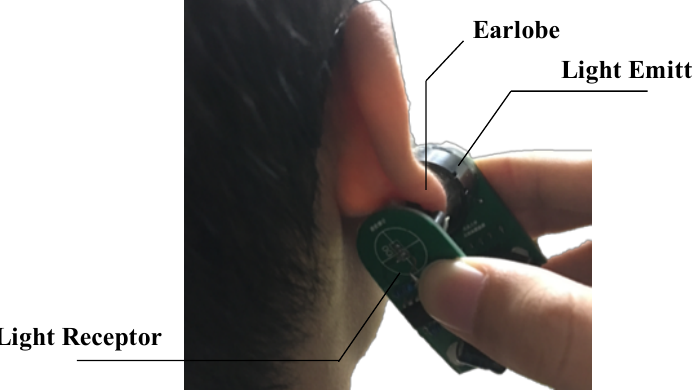
Figure 3. The demonstration of using the prototype of blood glucose sensor, which is used to clamp the earlobe from the upper and lower sides to allow the incident light to penetrate the tissue and the transmitted light to be received by the light receptor.